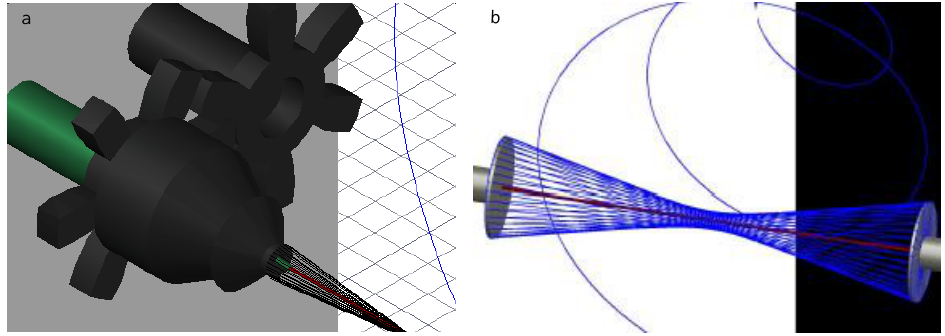
Figure 1. AutoCAD images of ( a ) the final design of the modified air-gap electrospinning with motor setup, signifying the stationary (green) and rotating (black) parts. ( b ) A simplified setup demonstrating the wrapping of electrospun fibers (blue) around the glass fiber (red).